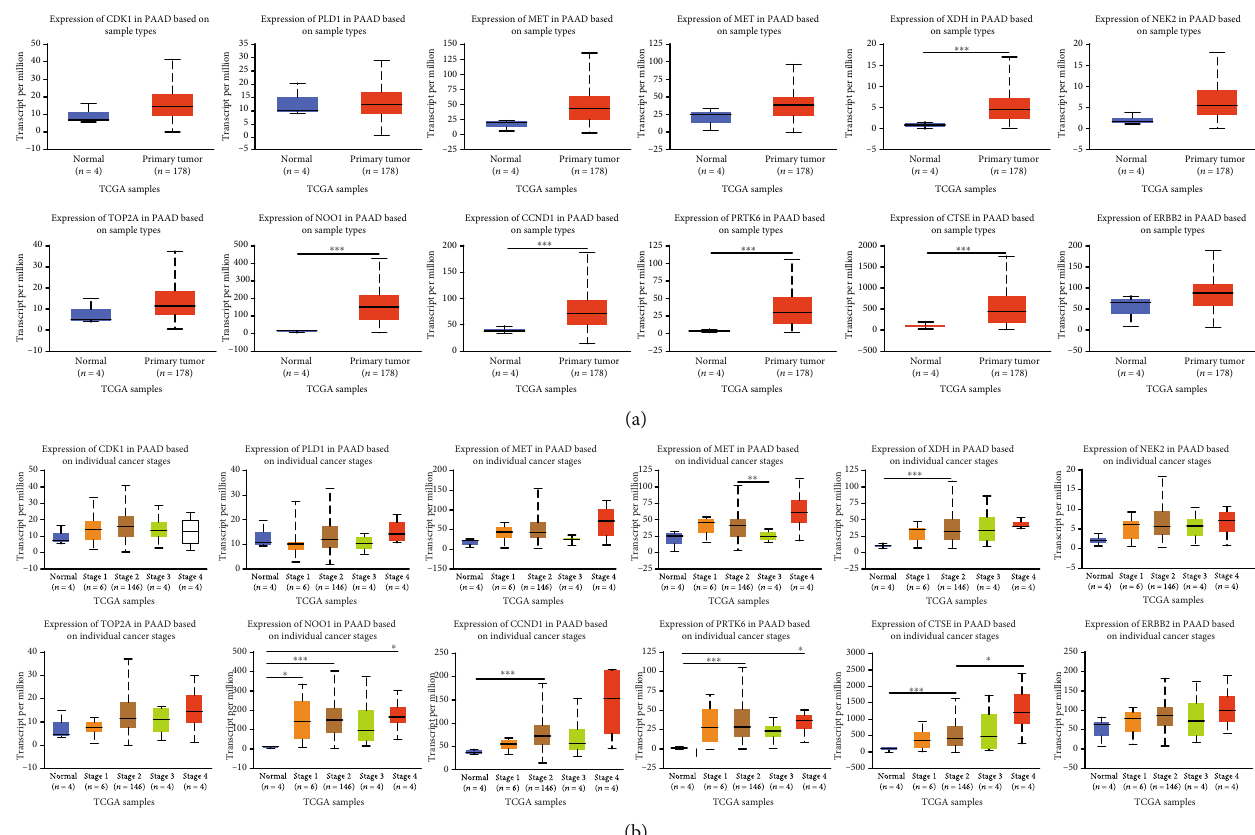
Figure 8: The mRNA expression levels of 12 overlapped DEGs in PDAC patients. (a) CDK1, PLD1, MET, F2RL1, XDH, NEK2, TOP2A, NQO1, CCND1, PTK6, CTSE, ERBB2 expression di ff erences between PDAC and normal tissues. (b) Expression of CDK1, PLD1,